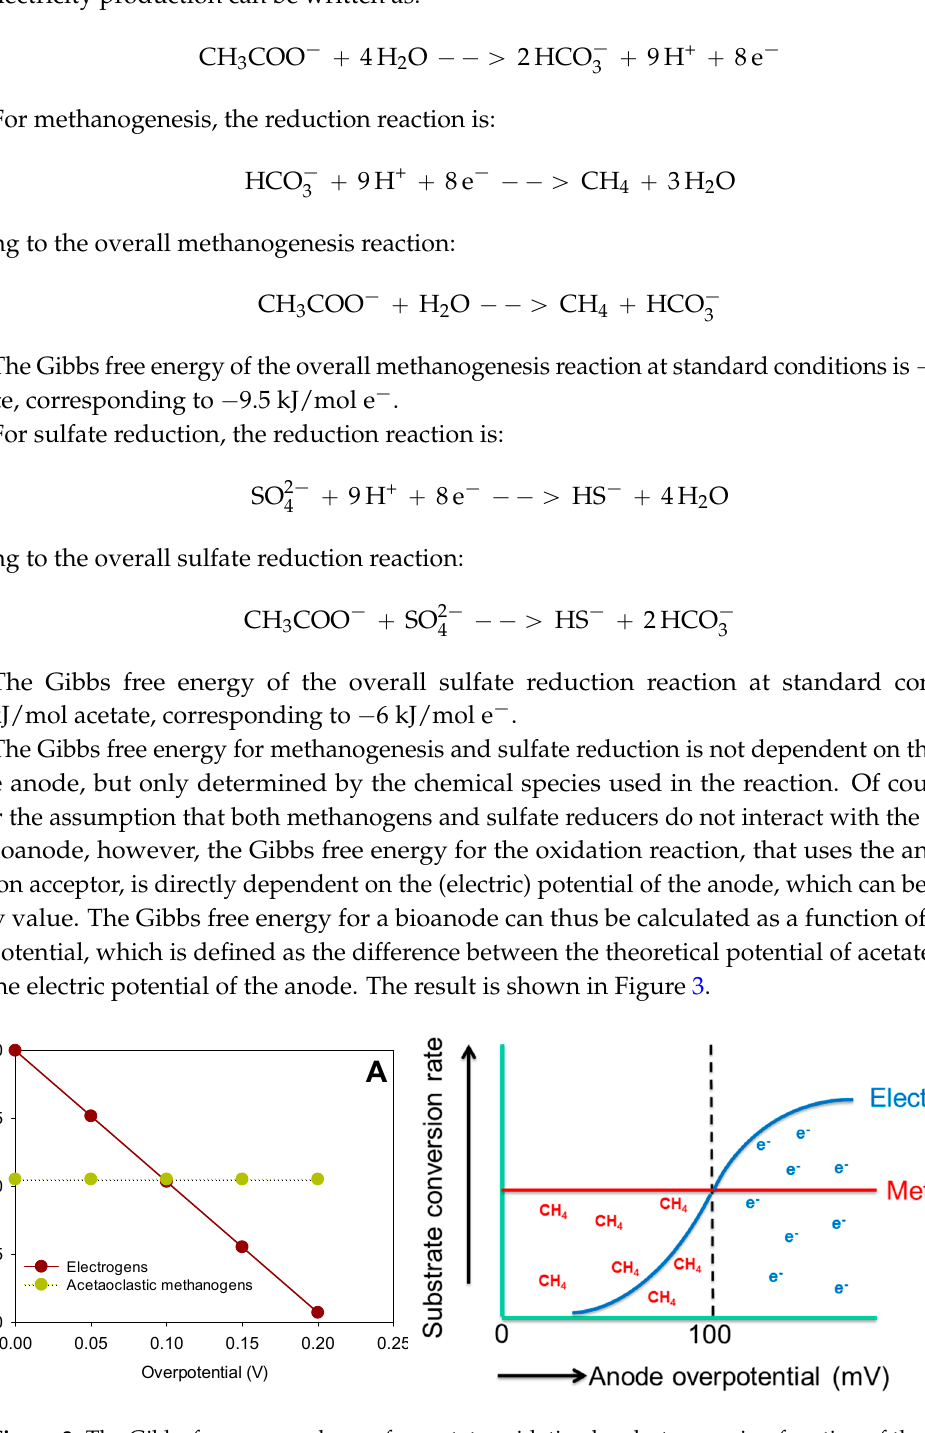
Figure 3. The Gibbs free energy change for acetate oxidation by electrogens is a function of the anode potential, while the growth rate of methanogens on acetate using acetate as the electron donor is independent of the anode overpotential. Consequently, at low overpotentials, methane is produced, and at higher overpotentials, current will be produced (right picture). The substrate conversion rate is related to the growth rate of the specific microorganism through the yield coefficient. Of course, the response of the specific microorganisms is dependent on other parameters, like, e.g., the type of microorganism, substrate concentration and pH.